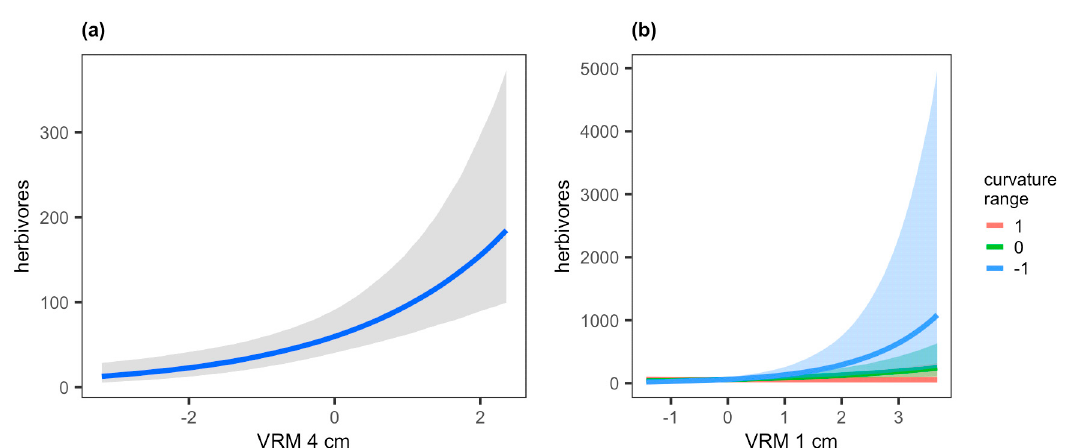
Figure 3. Conditional effect plots for ( a ) the standardized mean VRM deviation at 4-cm resolution and ( b ) the interaction between the standardized mean VRM at 1-cm resolution and the standardized curvature range showing the estimates of herbivore abundance per survey site.